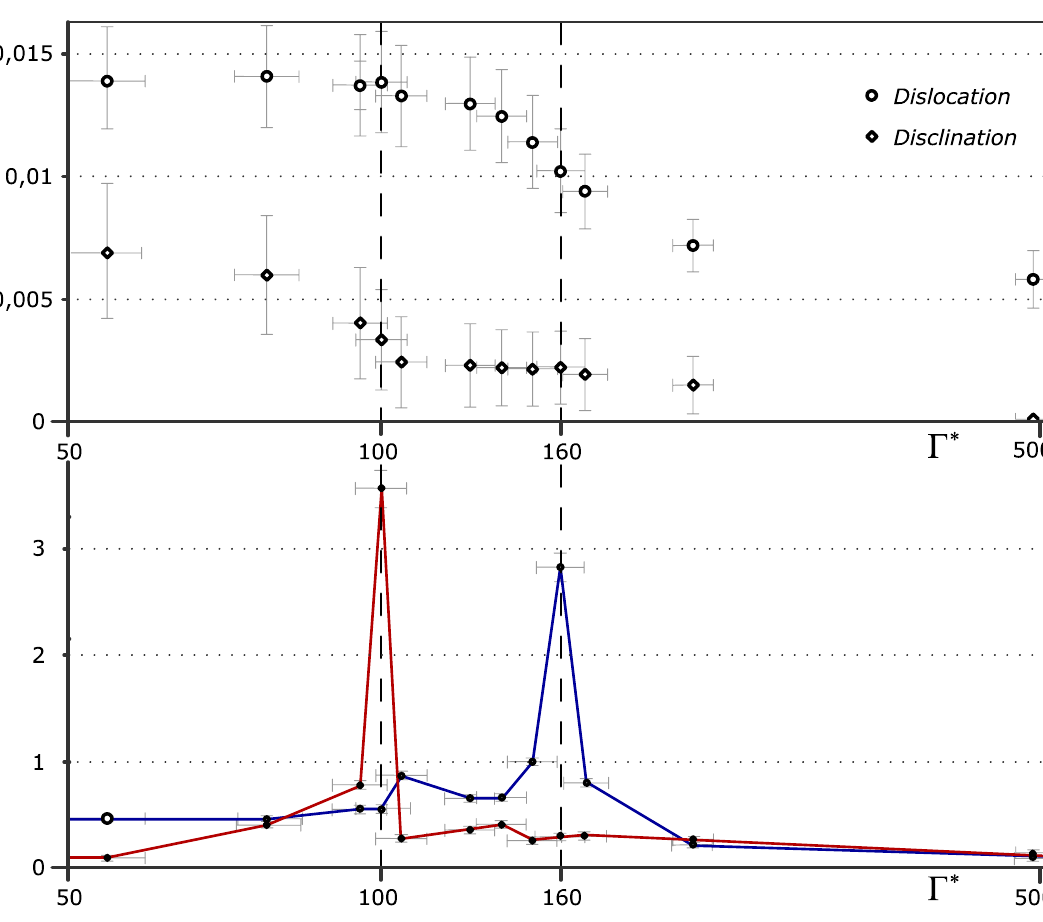
Figure 4. (top) Free dislocations (circles) and free disclinations (diamonds) relative fraction; (bottom) The translational, χ T , and orientational, χ 6 , susceptibilities as a function of coupling parameter Γ * . The divergence of * ~ 100 and Γ * ~ 160 (vertical dashed lines). χ χ T and 6 clearly indicates two transition points at Γ